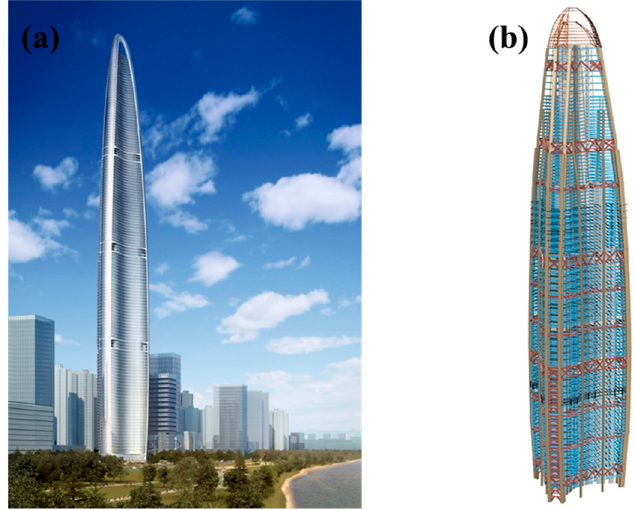
Figure 1. Wuhan Greenland Center (WGC): ( a ) architectural rendering; ( b ) architectural structure drawing.